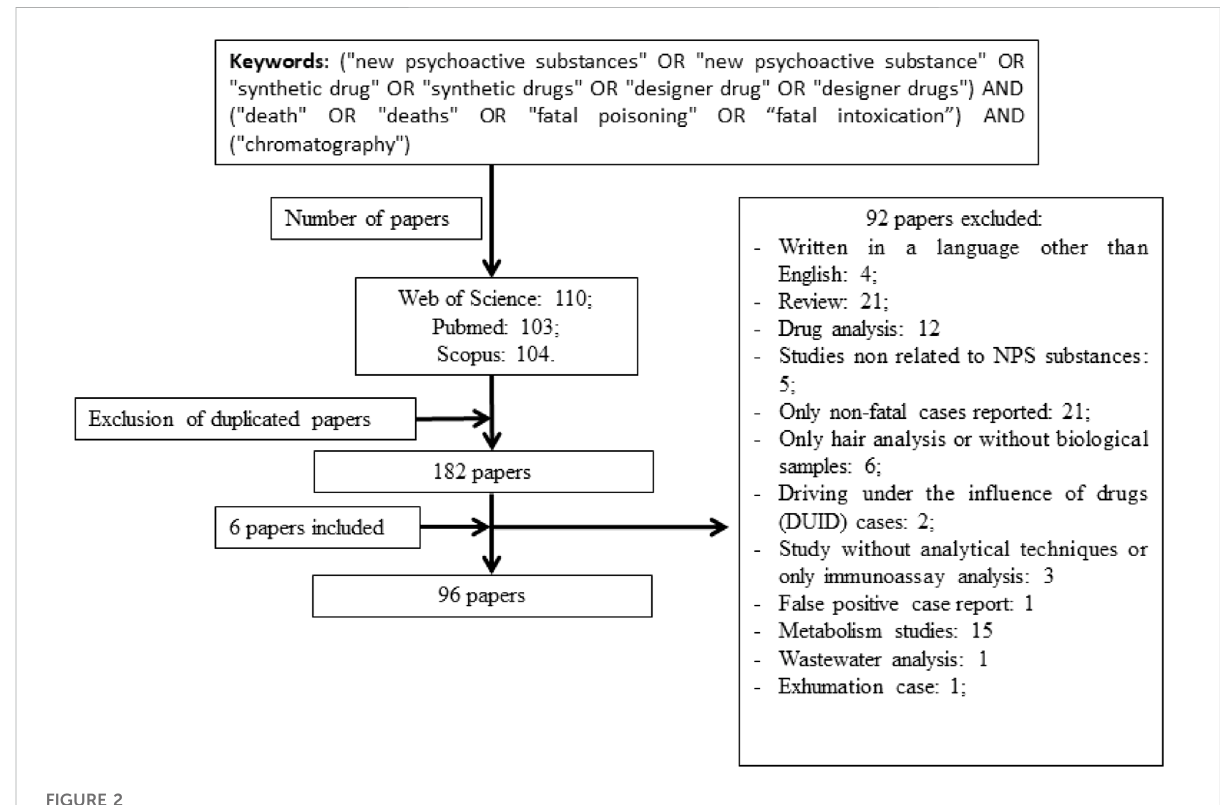
FIGURE 2 Paper selection